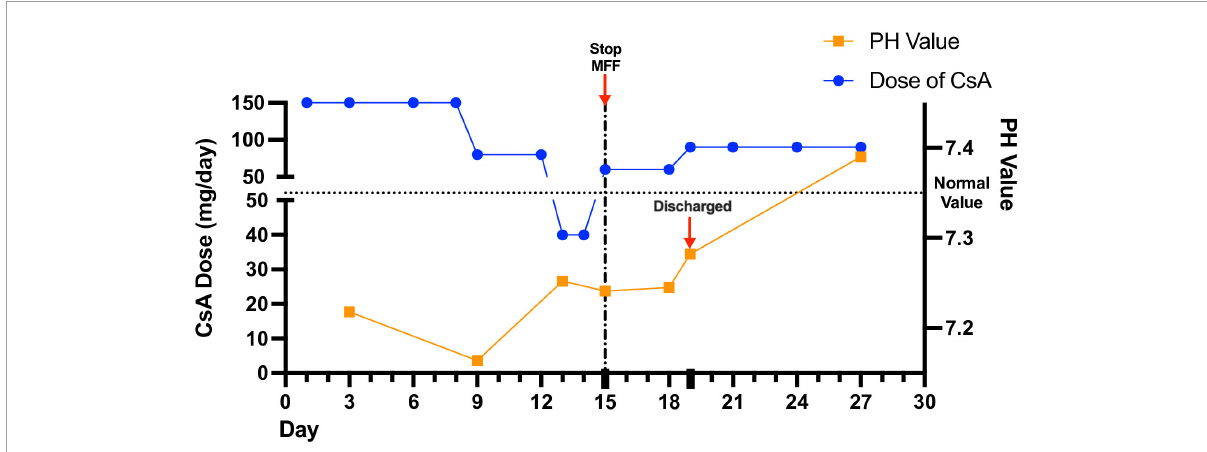
FIGURE1 Detailed blood gas analysis and immunosuppressant dose changes during and after hospitalization. The girl’s acidosis showed poor response to decreased dose of cyclosporine (CsA). Stopping the use of mycophenolate mofetil (MMF) led to attenuated